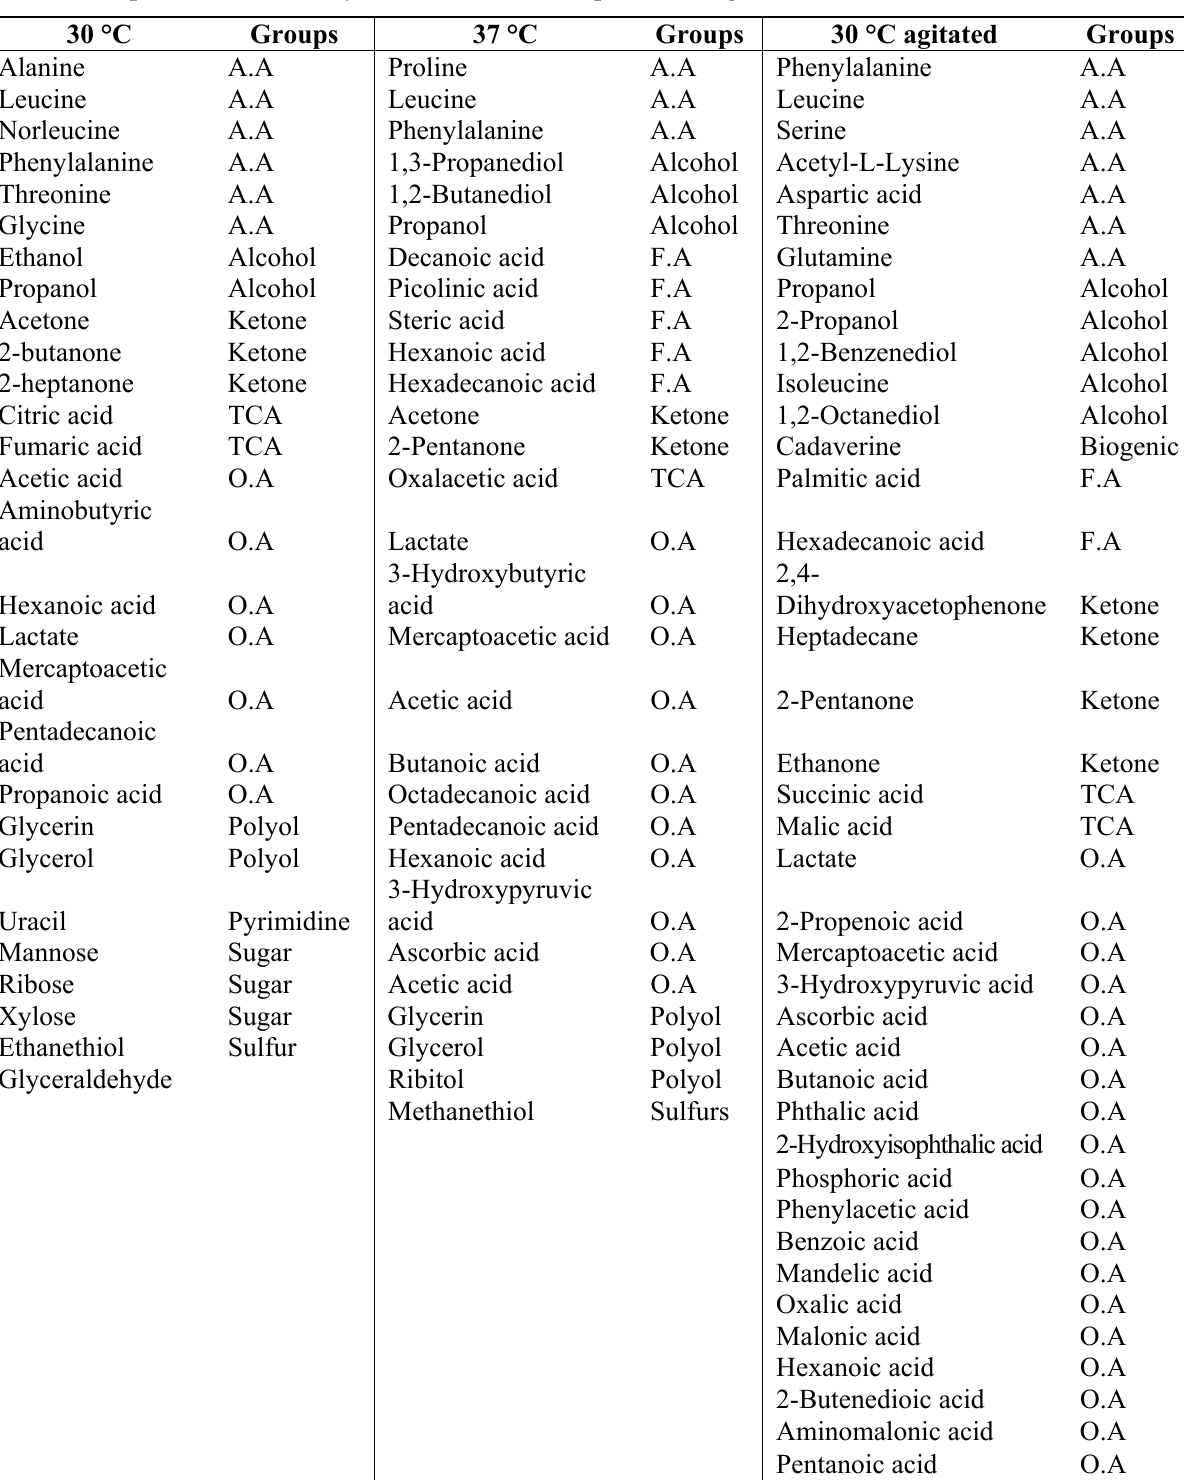
Table 1. Detected metabolites using TMS derivatization pooled according to conditions of 30 °C, 37 °C and 30 °C with agitation. A.A represents amino acid, F.A represents fatty acid, TCA represents tricarboxylic acid, and O.A represents organic